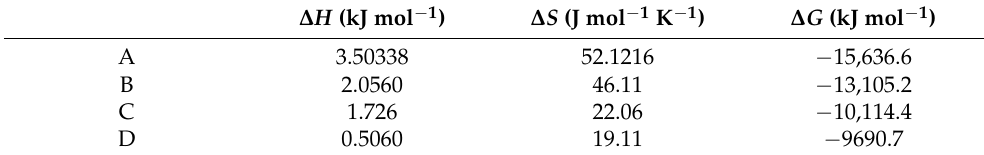
Table 6. Thermodynamic parameters of adsorption of 100 mg L − 1 Pb(II) onto A, B, C, and